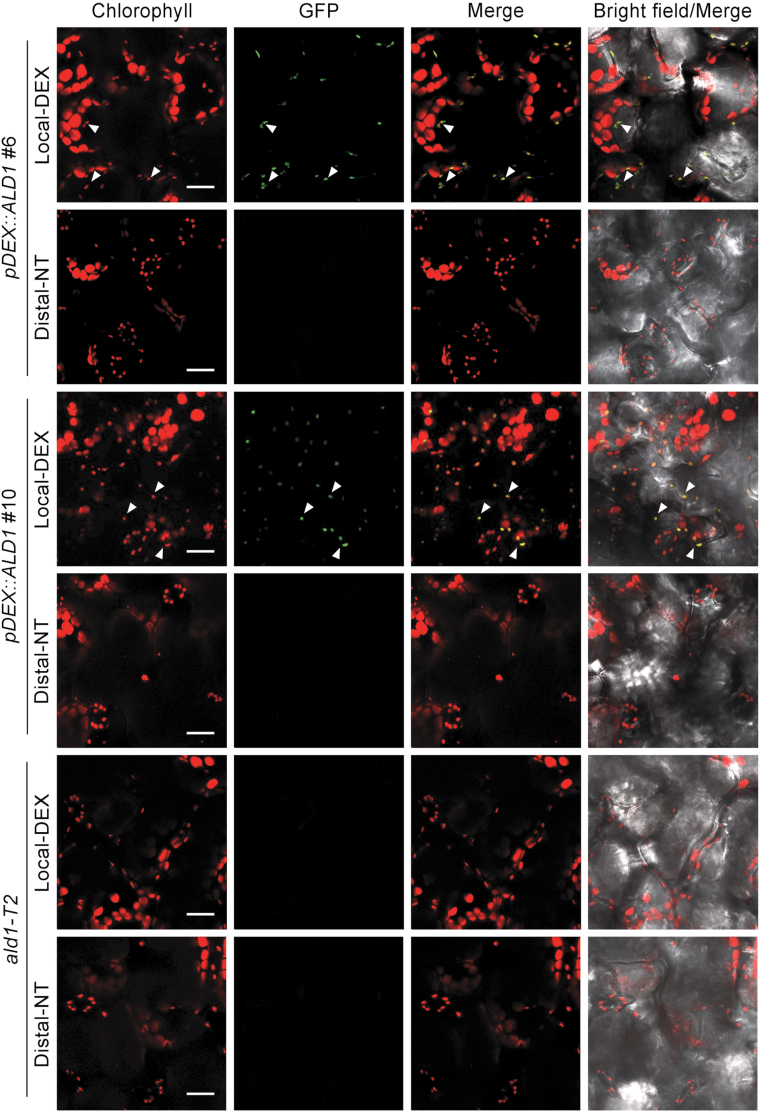
Accumulation of ALD1:GFP 4 d post-treatment only in leaves directly painted with DEX. Confocal Z-series maximum intensity projection showing images of DEX-inducible ALD1:GFP fusion protein in transgenic pDEX::ALD1 lines #6 and #10. DEX-treated local leaves (Local-DEX) and no-treatment distal leaves (Distal-NT) were collected at 4 d after 30 μM DEX painting on local leaves. The ald1-T2 mutant was used as a negative control. Chlorophyll autofluorescence is shown in red, and GFP fluorescence is shown in green. Scale bar=20 μm. Biological replicates: local leaves, n=6; distal leaves, n=3. White arrowheads indicate the representative chloroplasts and ALD1:GFP signals showing co-localization in the merged images. Similar results were observed in other independent experiments after 2 d DEX painting as shown in Supplementary Fig. S3.